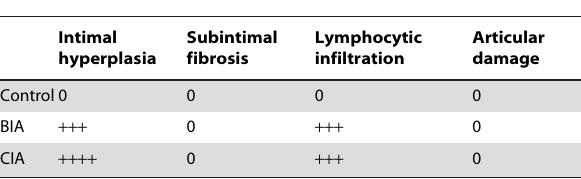
Table 1. Semi-quantitative evaluation of histological damage by a modified non-parametric scoring system in BIA and CIA mice.